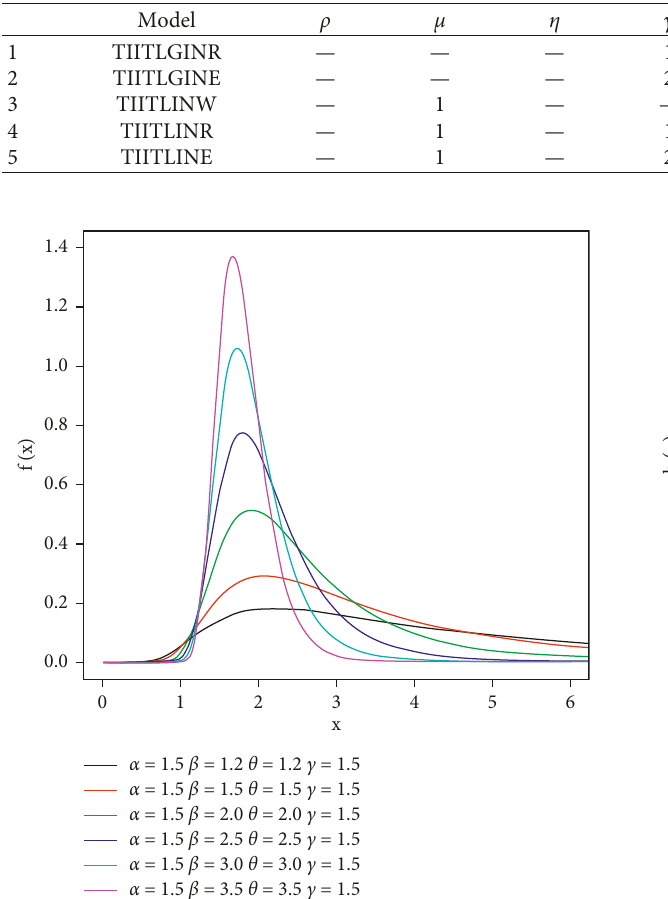
Table 1: Submodels of the TIITLGINW model.